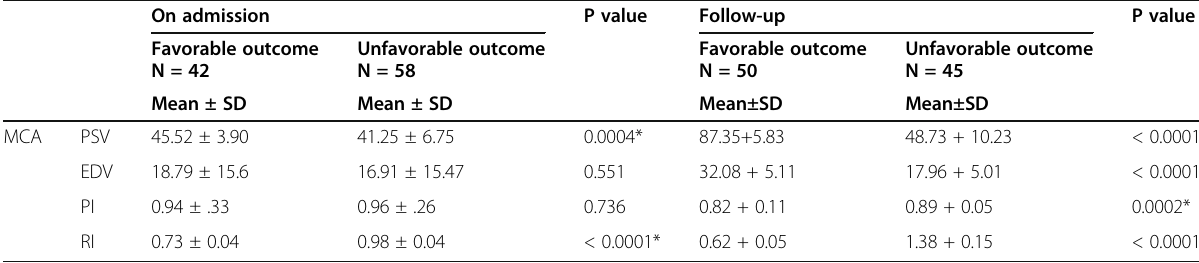
Table 3 Comparison of outcome regarding studied variables On